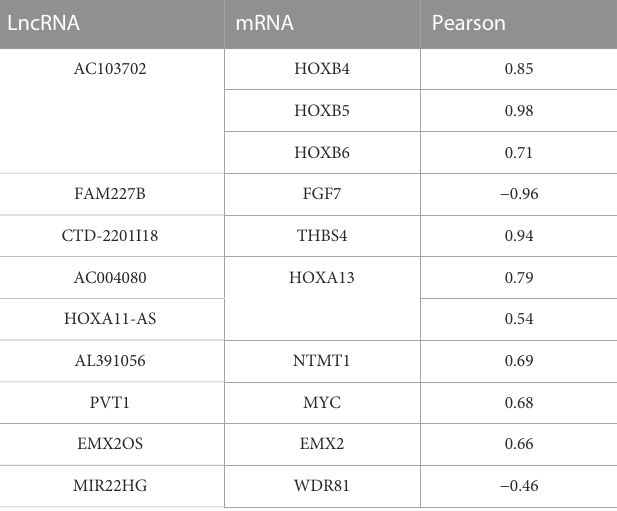
TABLE 3 Cis-regulation predictive analysis on the differentially expressed lncRNAs and mRNAs was performed according to the correlation coef fi cient.